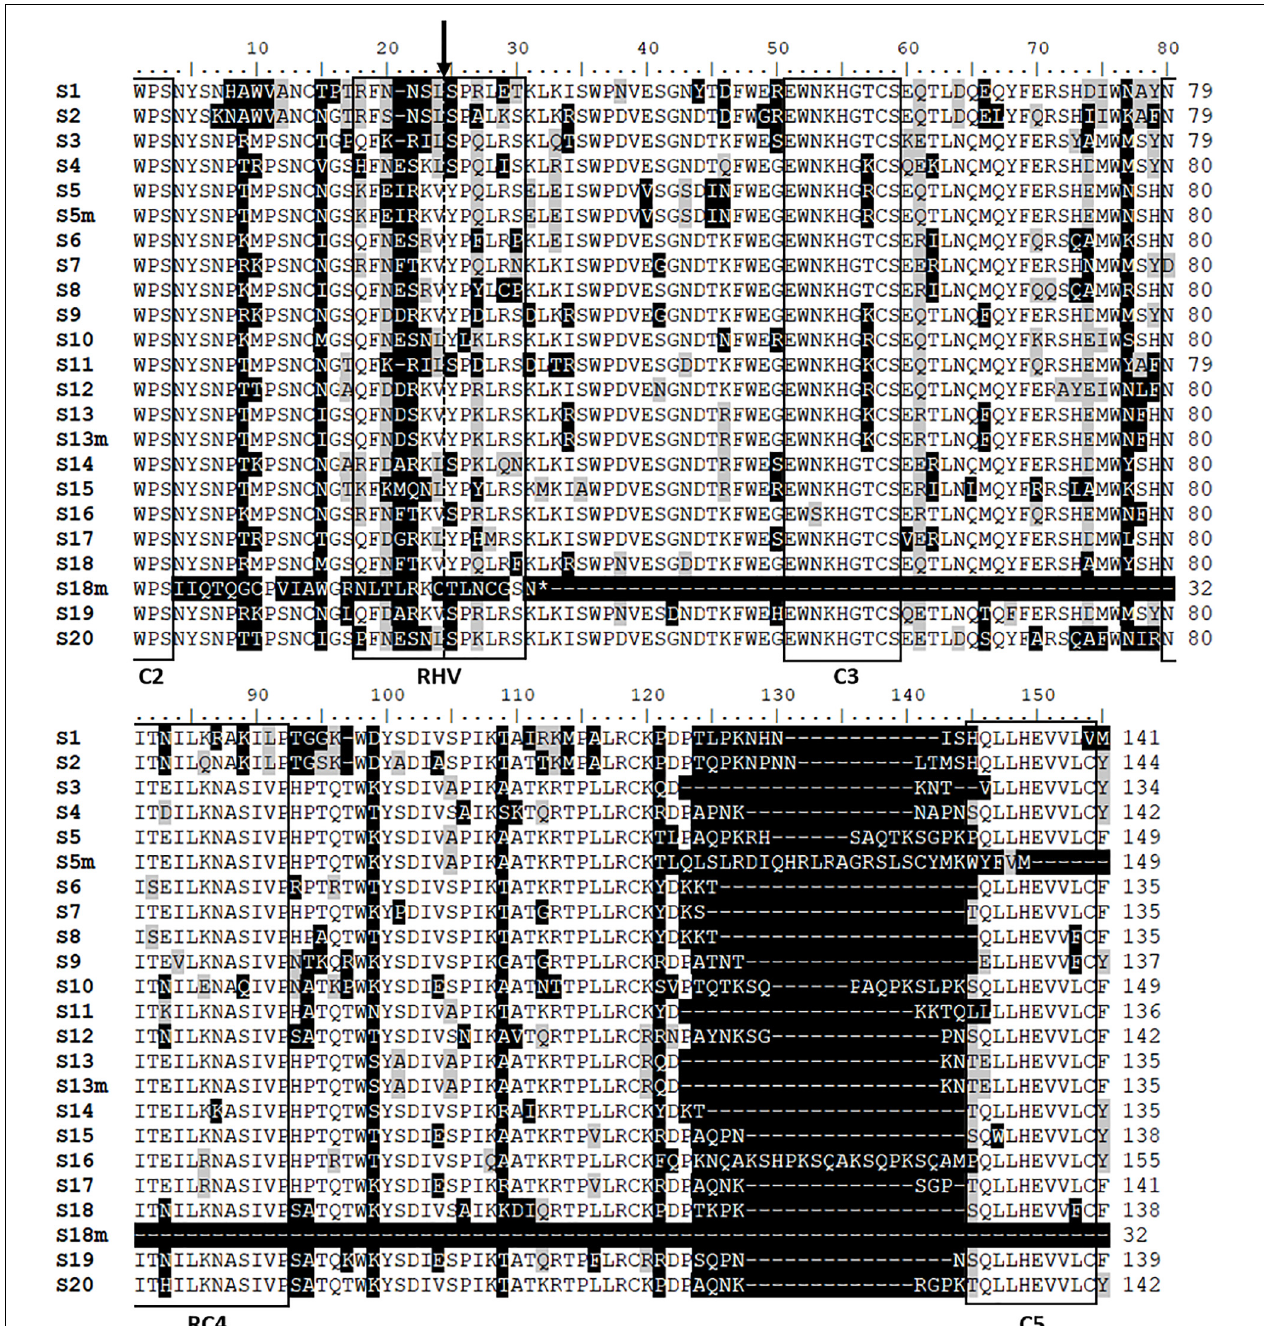
FIGURE 3 | Alignment of deduced partial amino acid sequences of the newly identified Prunus laurocerasus putative S -RNase alleles, S 1 – S 20 , and the three mutant alleles ( S 5m , S 13m , and S 18m ). The conserved (C2, C3, RC4, and C5) and the hypervariable region (RHV), characteristic of rosaceous S -RNases are boxed according to Ushijima et al. (1998). The position of the 2nd intron is indicated by an arrow. Partially conserved and highly polymorphic residues are shown against gray and black background colors,